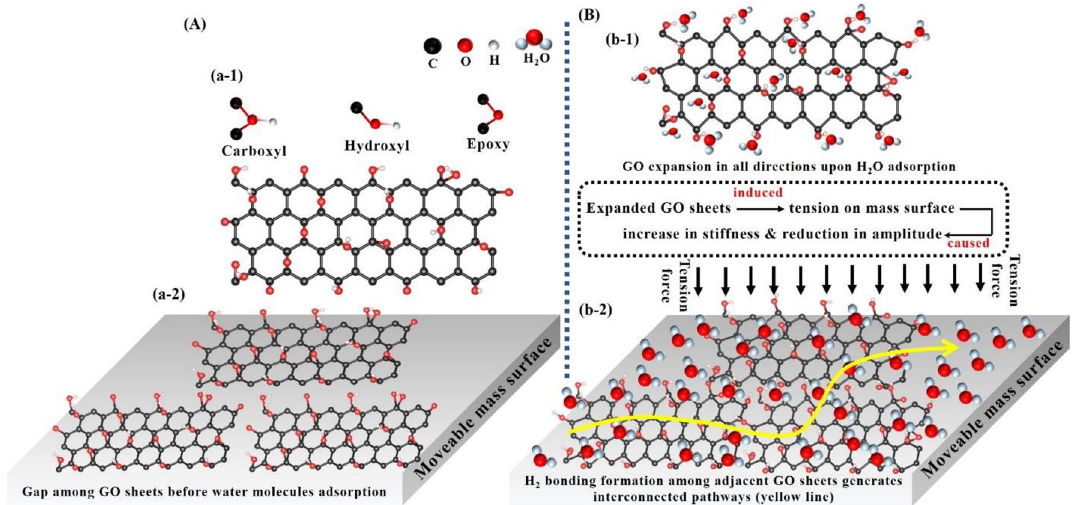
Figure 15. Sensing mechanism of water molecule adsorption on GO at the mass surface, ( A ) a schematic of GO sheets on moveable mass before water molecules exposure, (a-1) the front view of GO sheet with different functional groups attached on its surface (epoxy, hydroxyl, and carboxyl), (a-2) GO sheets on the moveable mass surface which indicates a gap among adjacent GO in the absence of water molecules, ( B ) a schematic of GO sheets on moveable mass after water molecules exposure, (b-1) illustrates the expansion of the GO sheet in all directions when water molecules form a bond with oxygen functional groups, (b-2) demonstrates the expansion values at the mass